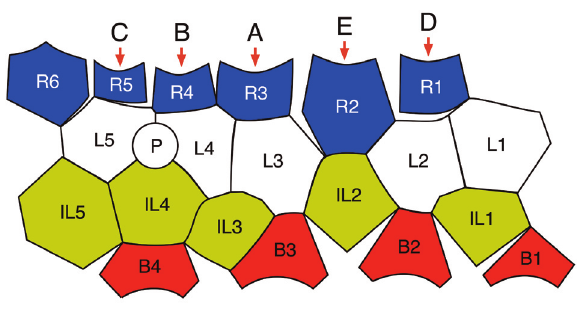
Fig. 8. Plate diagram for the glyptocystitid genus Pirocystella Sprinkle, 1982. Note that the infralateral circlet is interrupted in two places with B2:L2 and B3:L3 sutures, and the lateral circlet once, with the IL2:R2 suture. A–E, ambulacra, which align with the radial plates R1 to R5 (arrows); B1–B4 basal plates; IL1– IL5, infralaterals; L1–L5; laterals; P, periproct; R1–R6, radial plates. Redrawn from Sprinkle (1982, fig. 62B, p.